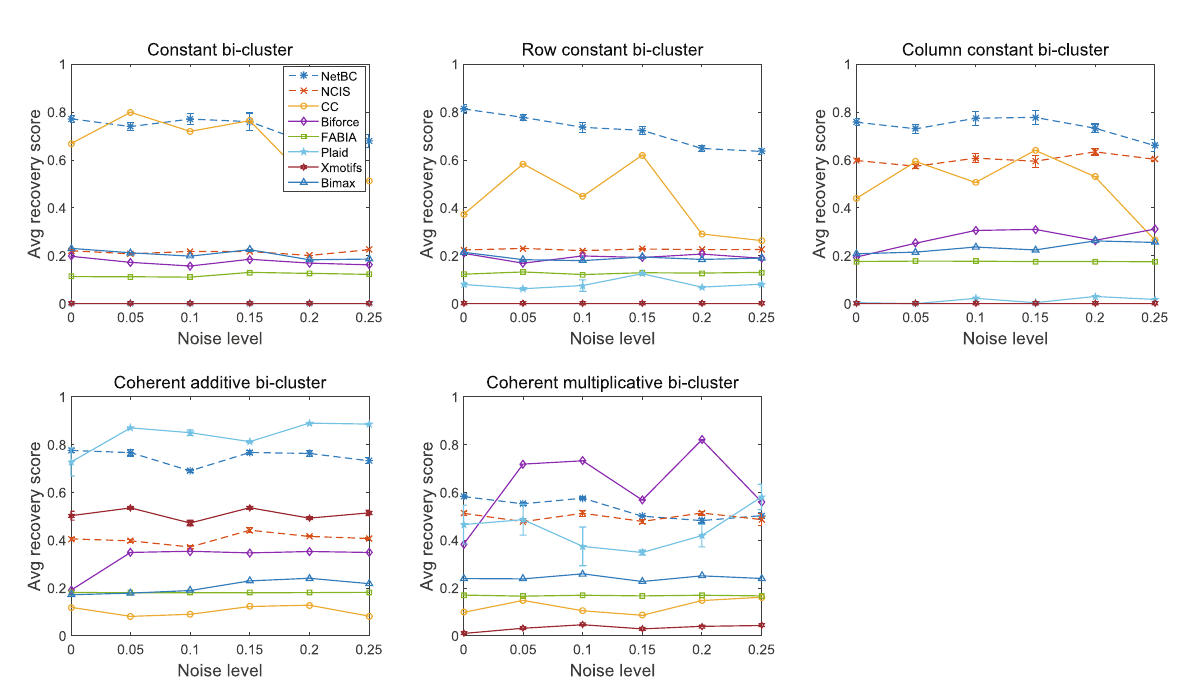
Figure 7. Recovery of bi-clustering methods on five types of